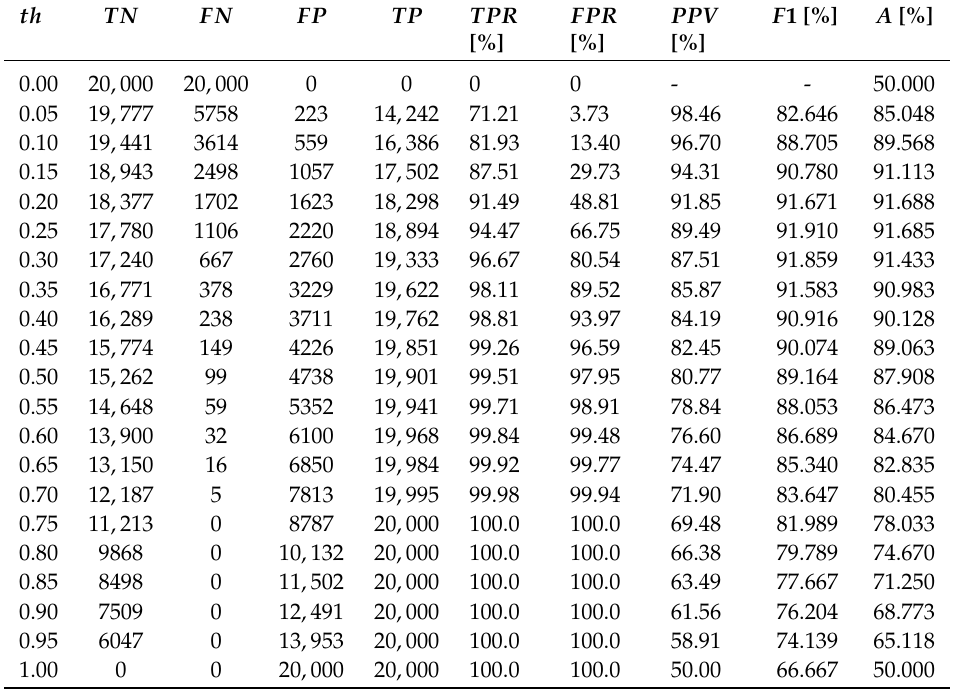
Binary classification metrics for the Appearance Affinity model learnt with the Double-Margin-Contrastive loss